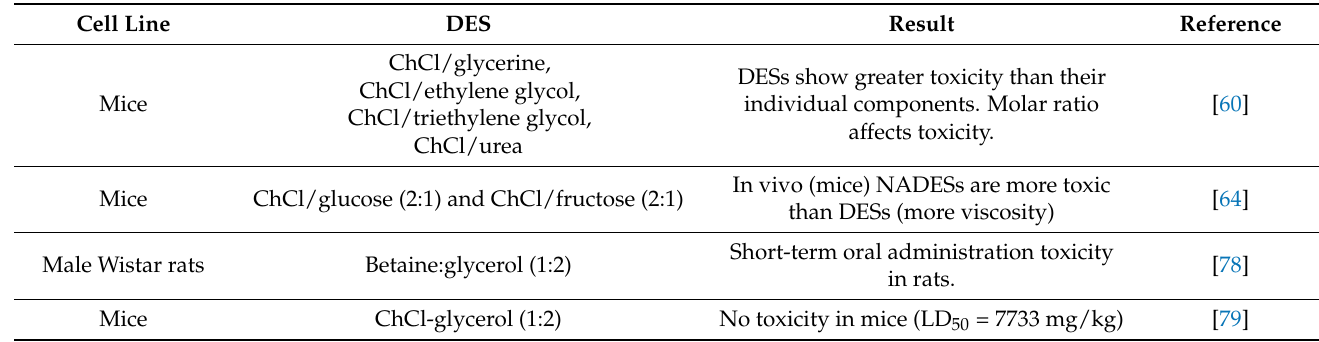
Table 2. Cytotoxicity assays of DESs in